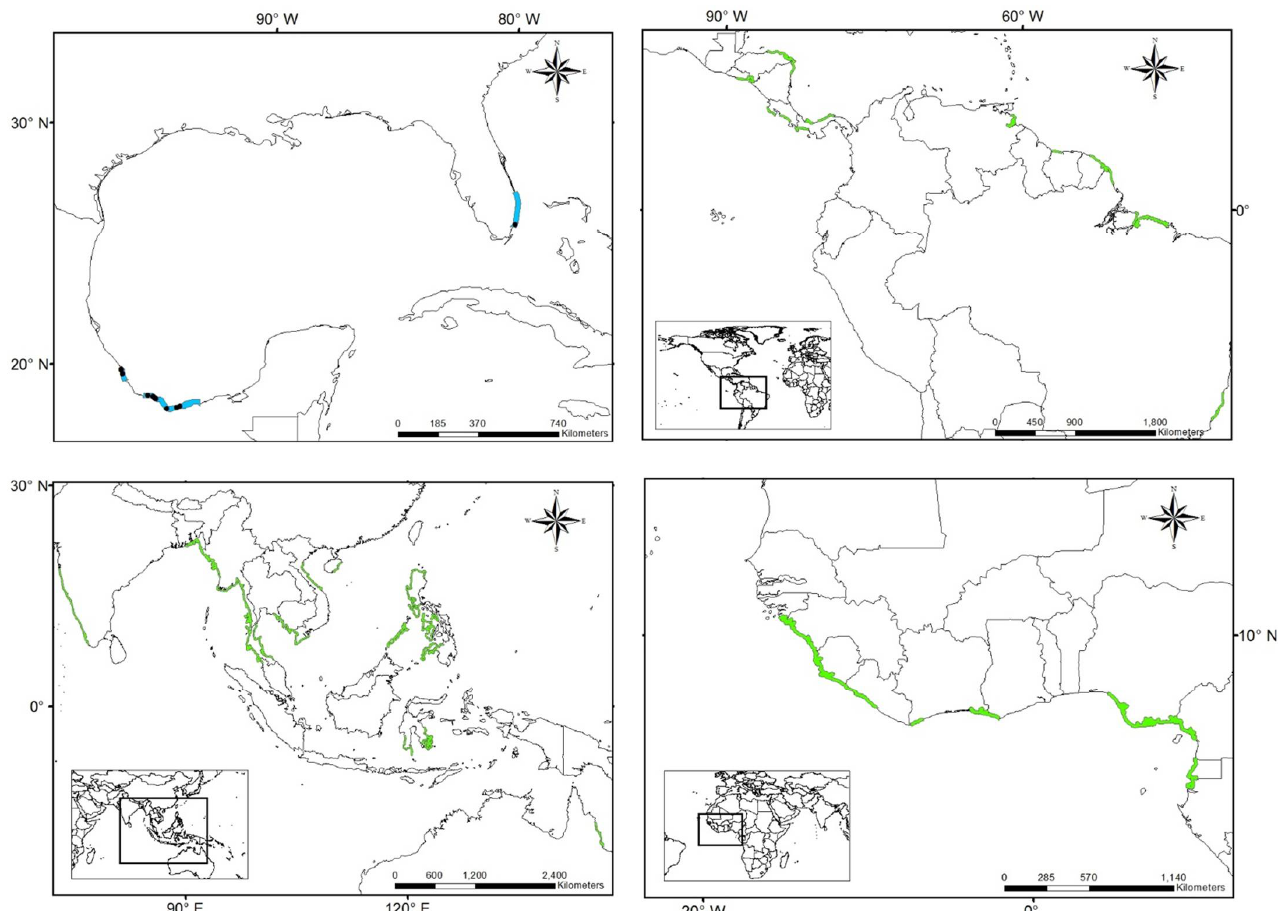
Figure A1. Training (blue) and projection (green) areas for the construction of the models corresponding to Tropical monsoon climate (Am). Black dots represent occurrence records.